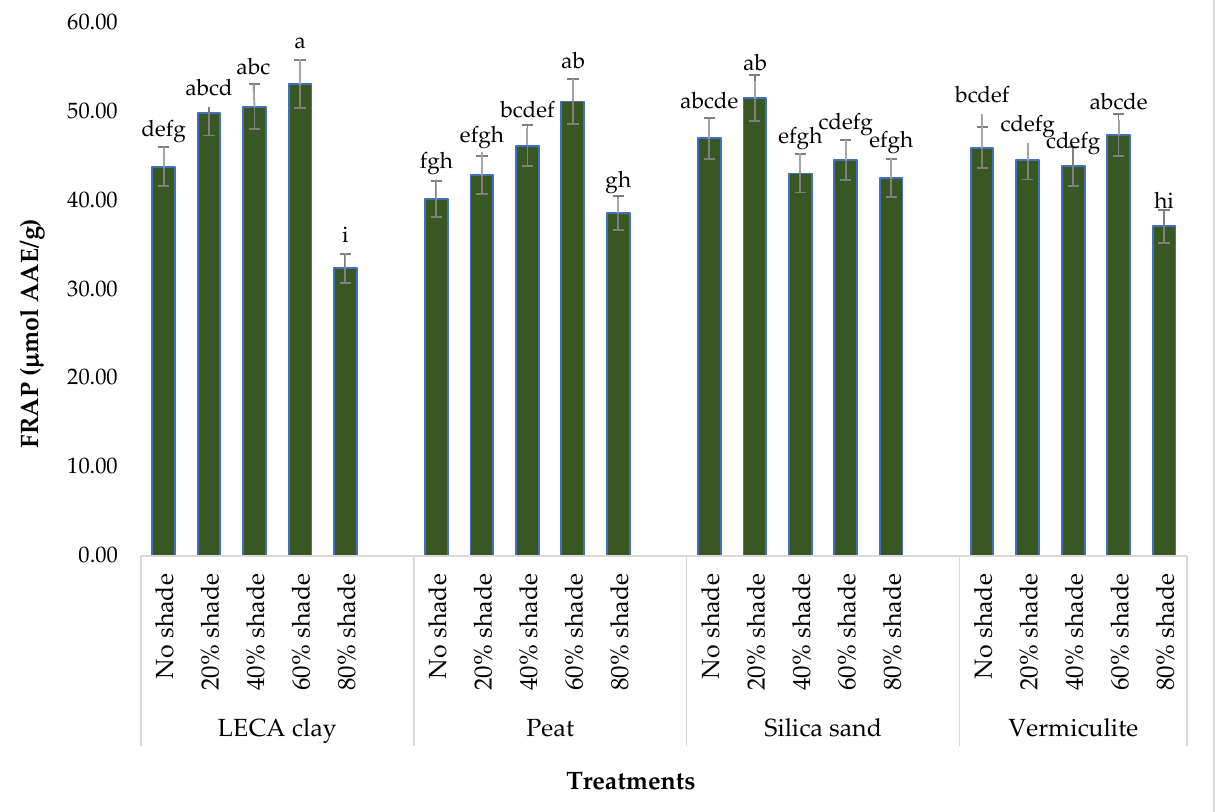
Figure 9. The effect of different growth media and different shade levels on total FRAP content in the flower buds of T. divaricata . Means followed by the same letter did not differ by Tukey’s test ( p > 0.05).